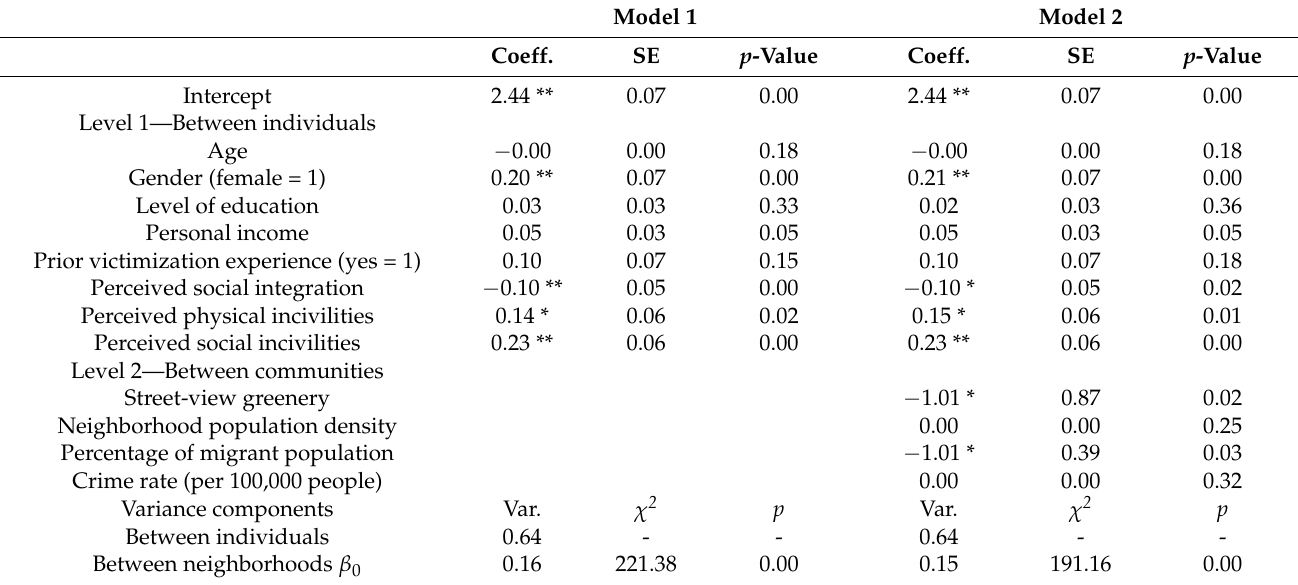
Table 2. Multilevel results of the effect of street-view greenery on fear of crime (with robust standard